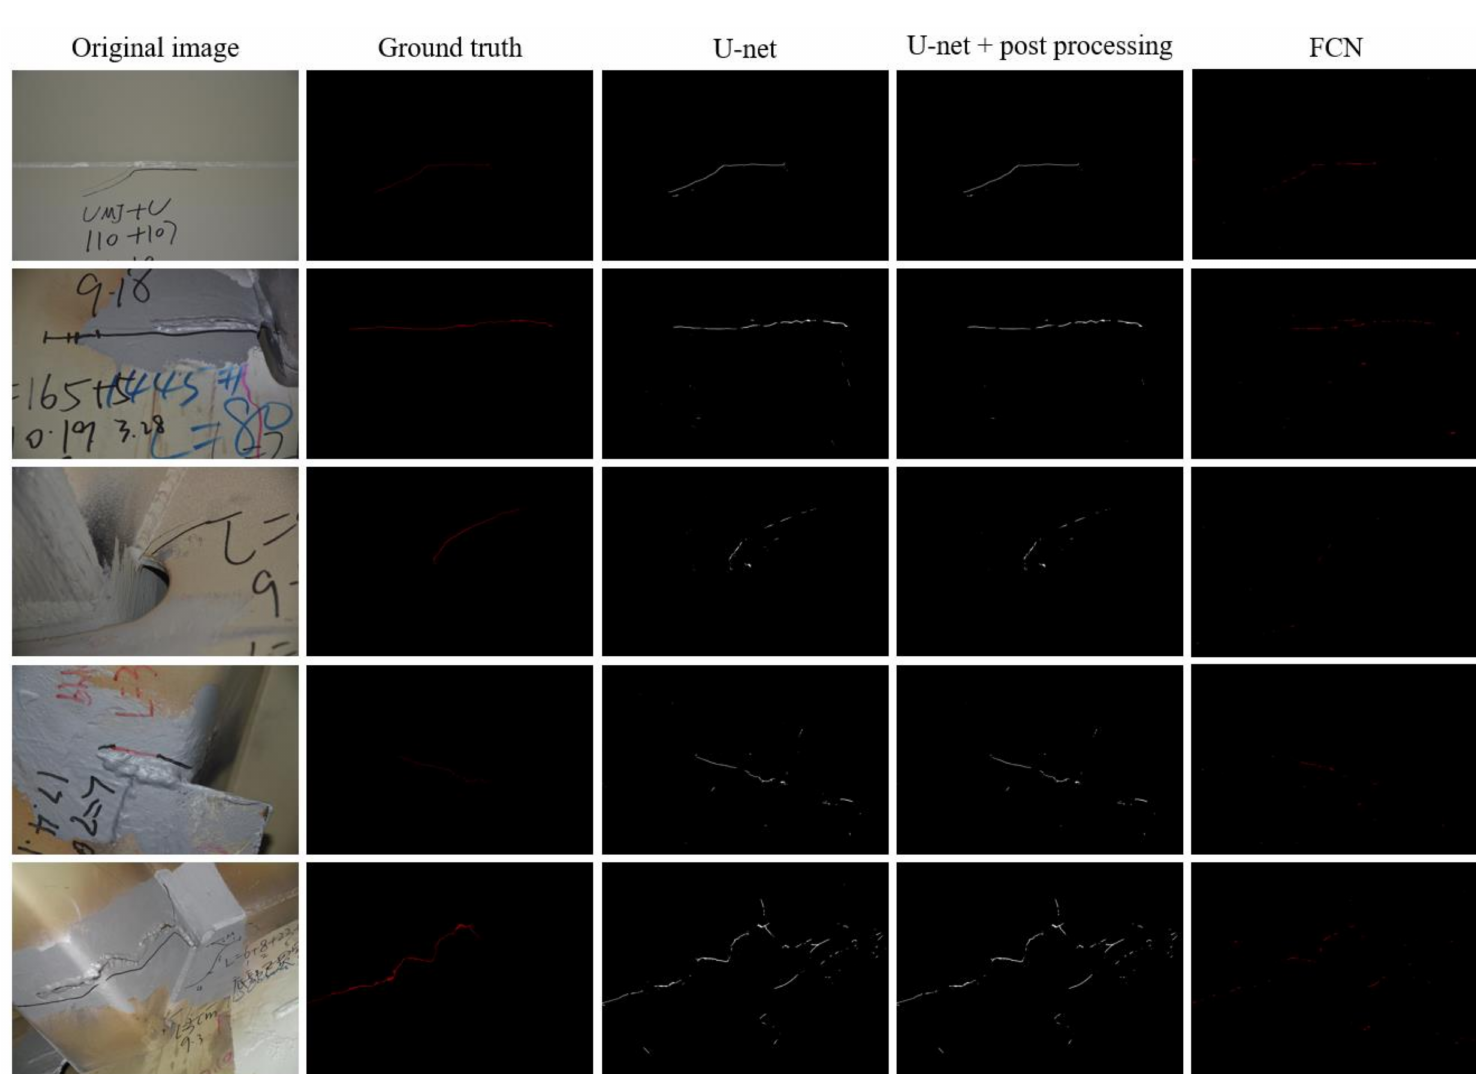
Figure 6. Prediction examples on the original test dataset with large